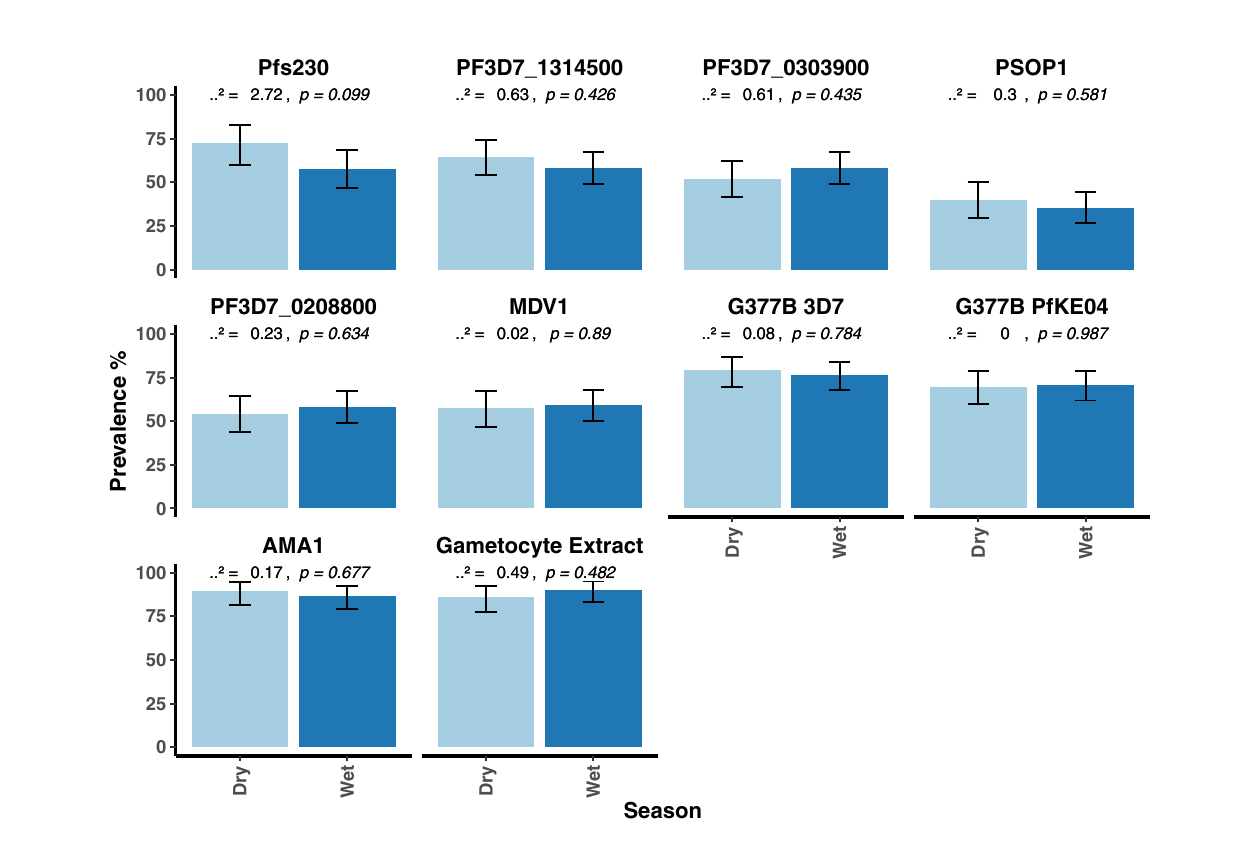
FIGURE 4 | Seroprevalence to the candidate antigens, AMA1 and gametocyte extract strati fi ed by season in the AFIRM cohort. Bar plots showing the prevalence of antibodies to the candidate antigens, AMA1 and gametocyte extract in the dry and the wet seasons. A Chi-square-test was used to compare proportions between the dry and wet seasons. Respective p values are presented at the top of each panel. Error bars show 95% binomial con fi dence intervals (Clopper – Pearson